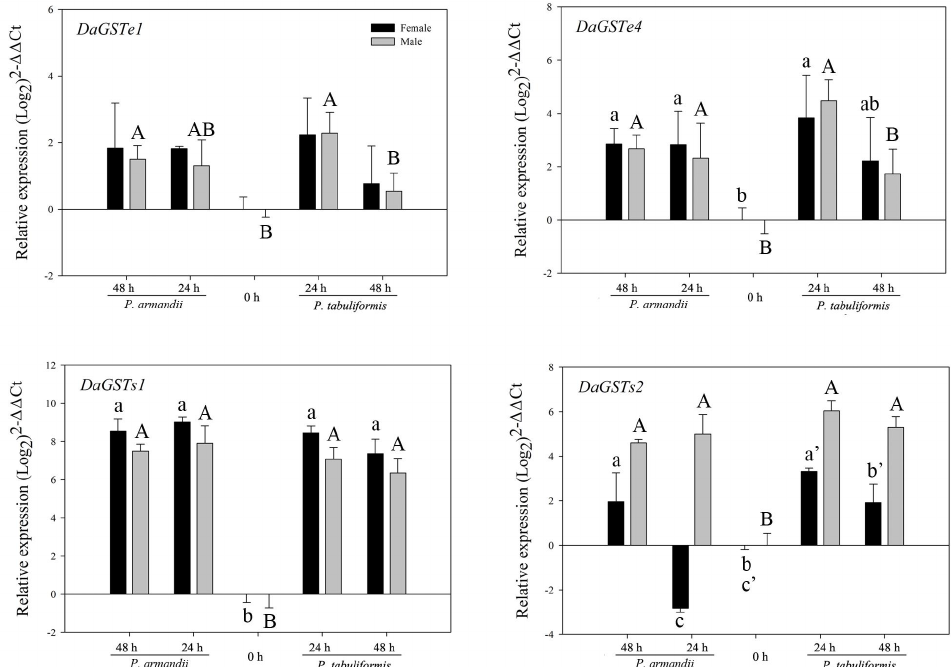
Figure 3. Realtime qPCR analysis of the relative expression of four GST genes (mean ± SE) in D. armandi after being fed on two different diets for 24 and 48 h. Values > 1 on the logarithmic y-axis indicate upregulation. Gene expression was normalized with respect to the geometrical mean of β -actin and CYP4G55. The different letters indicate statistically significant differences in gene expression among different times for the same diet, compared using Tukey’s HSD ( p < 0.05). The 2 − ∆∆ Ct and SE values were log 2 transformed for plotting.